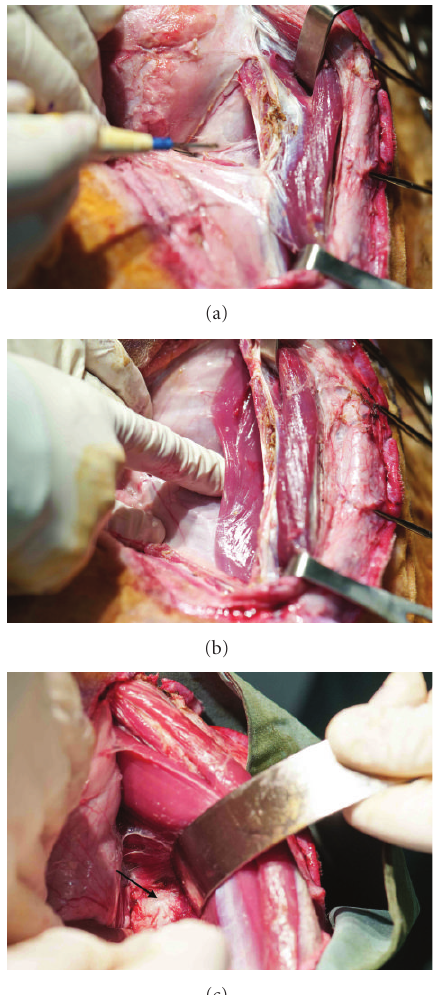
Figure 4: (a) Division of thoracolumbar fascia at its attach- ment to the transverse processes allows entry into retroperitoneal space. Erector spinae muscle is retracted laterally. (b) With the thoracolumbar fascia divided the psoas muscle becomes visible. The peritoneum can be carefully separated from the posterior abdominal wall musculature with blunt dissection. (c) Psoas muscle retracted laterally and abdomen retracted medially revealing the intervertebral disc